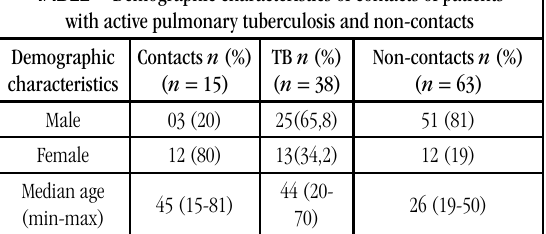
tABLE – Demographic characteristics of contacts of patients with active pulmonary tuberculosis and non-contacts Demographic